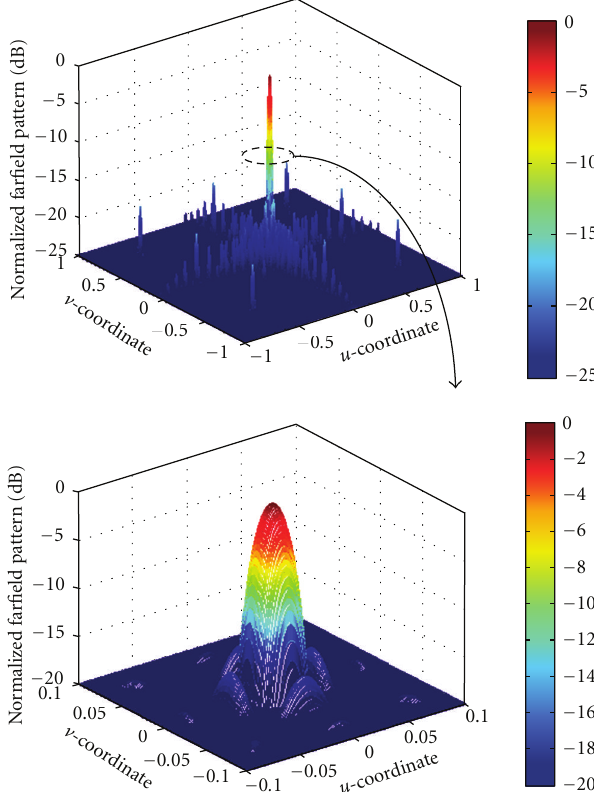
Figure 9: Radiation pattern of the optimized stage 4 Sierpinski carpet array.